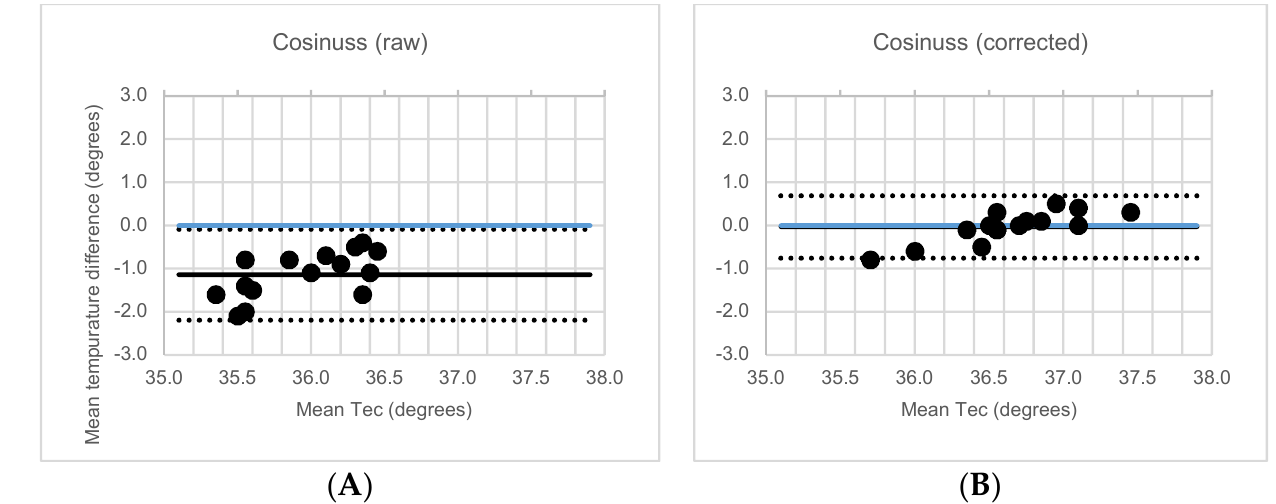
Figure 4. Bland-Altman plots of the mean ear canal temperature versus the mean temperature difference. The ear canal temperature (TEC) measured with non-corrected ( A ) Cosinuss ◦ and corrected ( B ) Cosinuss ◦ compared to the IR thermometer with mean and upper and lower limit of agreement (LoA). Table 3. Cosinuss ◦ non-corrected and corrected per subject. The Cosinuss ◦ was compared with the IR thermometer per company using the intraclass correlation coefficient (ICC) with a confidence interval of 95% and p -value.